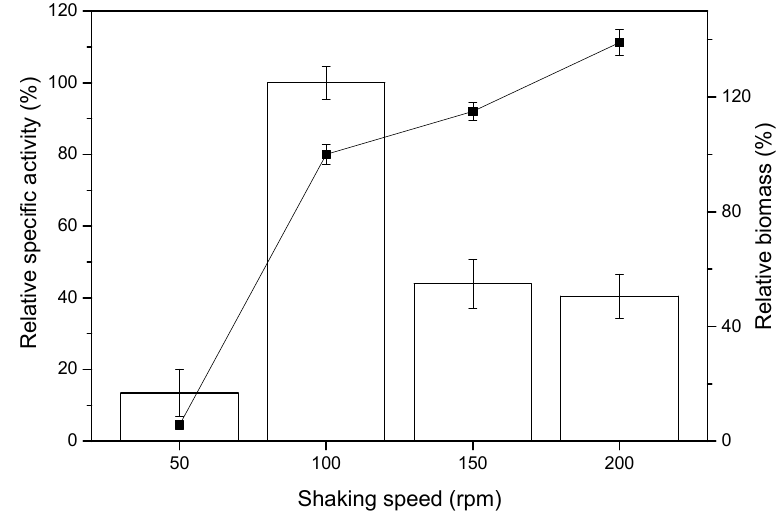
Figure 3. Effect of shaking rate on the specific activity (bars) and biomass production (black squares) of sdCALA. To calculate relative values, the value measured at 100 rpm was set as 100%. Table 2. Effect of mass transfer and shear rate on the specific activity and biomass production of sdCALA.